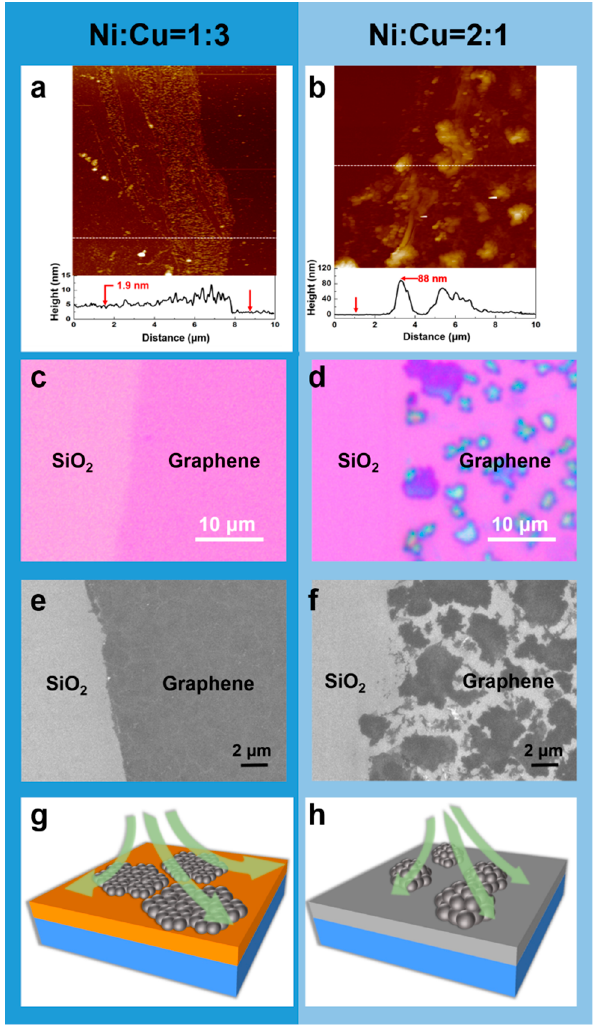
Figure 2. ( a , c , e ) The AFM, optical and SEM images of the graphene grown on the Ni1Cu3 alloy, respectively. ( b , d , f ) The AFM, optical and SEM images of the graphene grown on the Ni2Cu1 alloy, respectively. ( g , h ) The diffusion mechanism of carbon atoms on Cu and Ni surfaces, respectively.